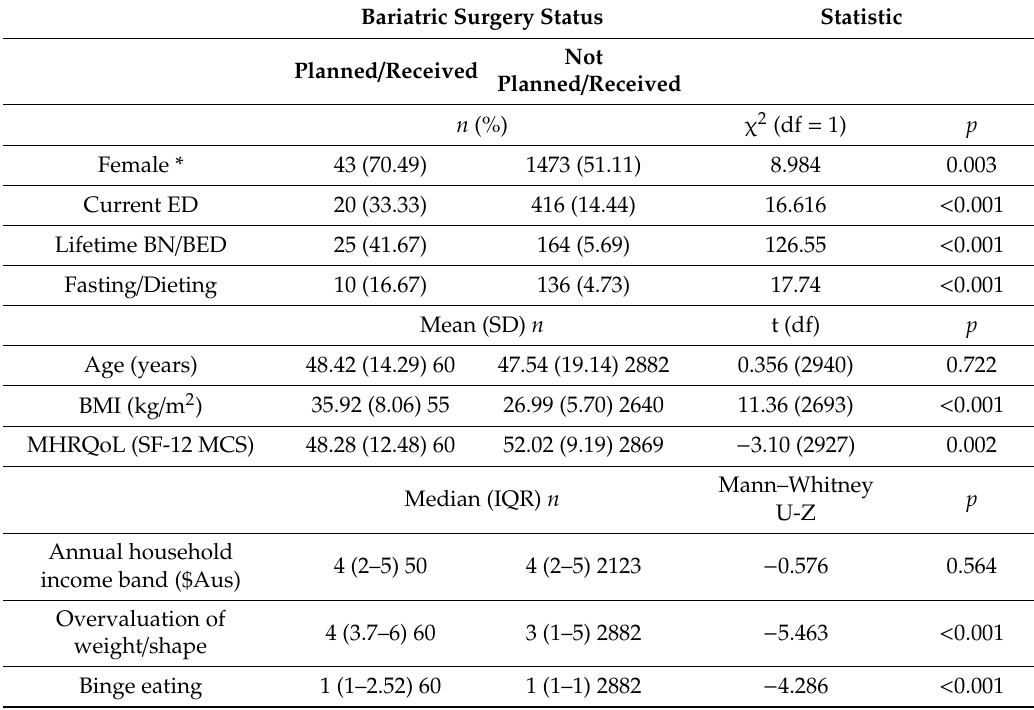
Table 1. Demographic, mental health and eating disorder (ED) features of people who had planned or received bariatric surgery ( n = 60) and not planning or having received bariatric surgery ( n = 2917). Bariatric Surgery